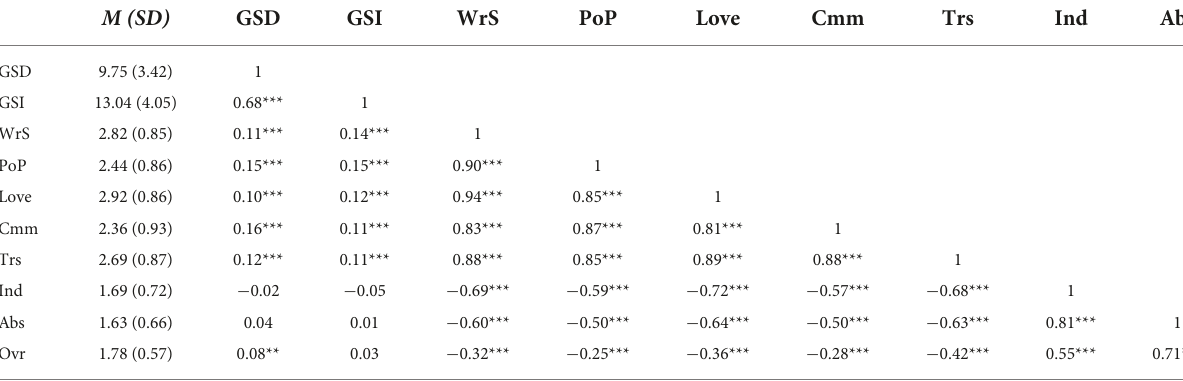
TABLE 1 Means, standard deviations, and bivariate correlations for the German sample.